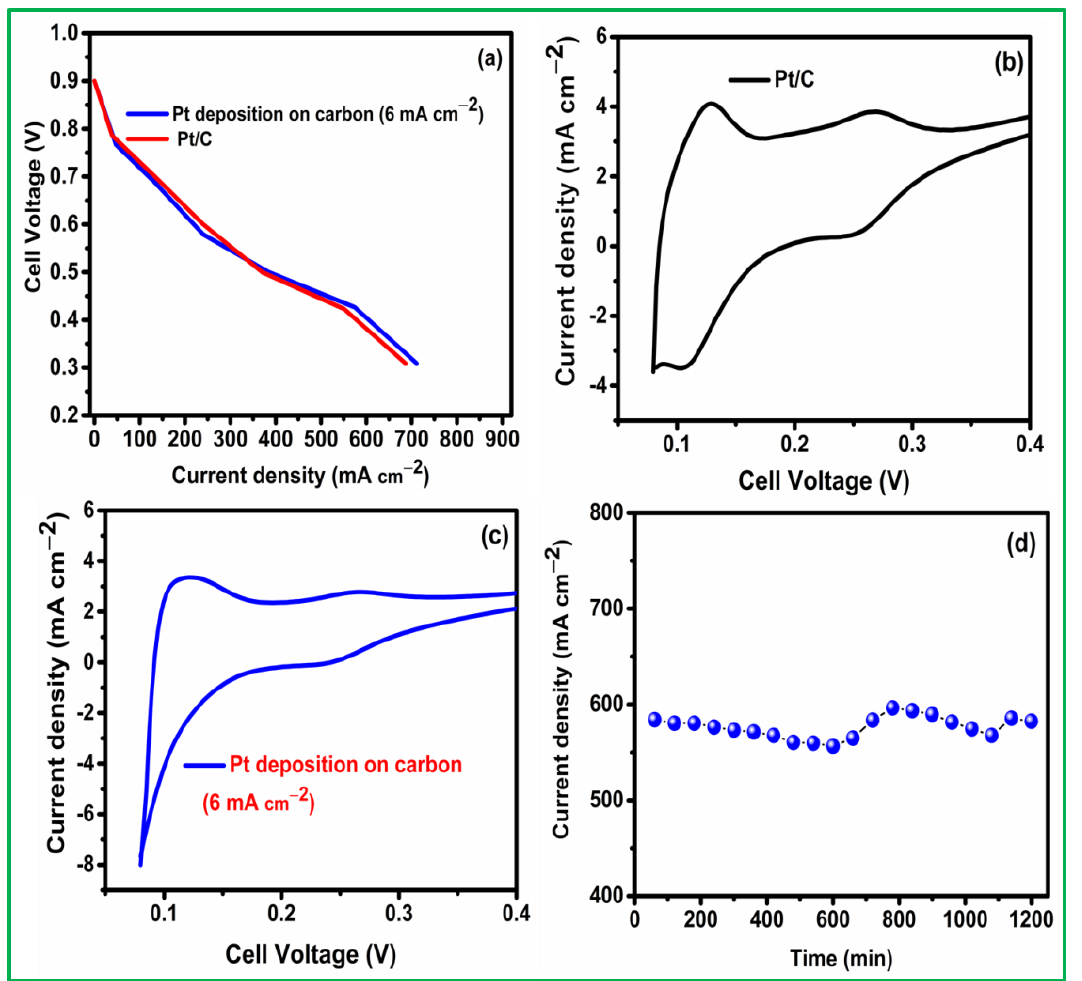
Figure 7. ( a ) Fuel cell performance, ( b , c ) H 2 adsorption and desorption behaviour of Pt/C and Pt deposited on carbon (6 mA cm −2) , and ( d ) stability test at 0.4 V for Pt deposited on carbon (6 mA cm −2 ).